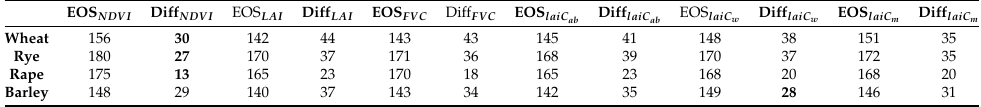
Table 3. Mean values for End of Season (EOS) in day of year and its mean difference from the harvest date (Diff) in days, for each crop trait and crop type. The smallest differences are written in